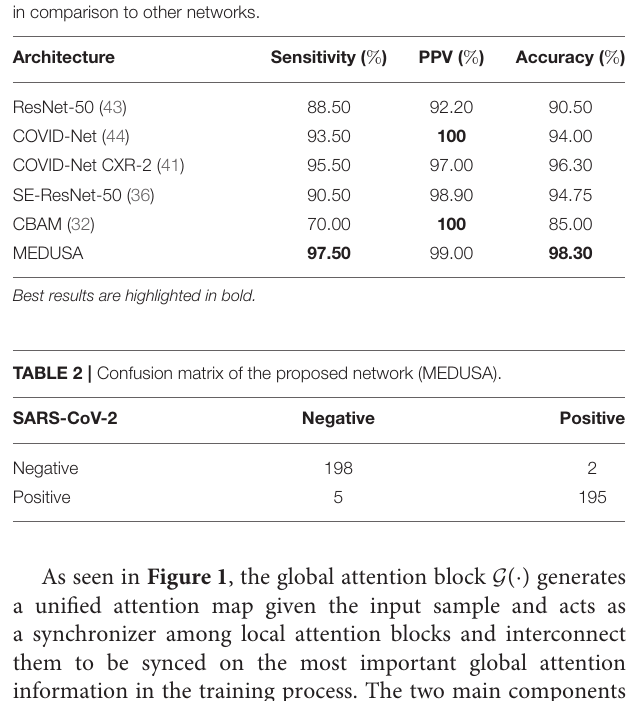
TABLE 1 | Sensitivity, positive predictive value (PPV), and accuracy of the proposed network (MEDUSA) on the test data from the CXR benchmark dataset in comparison to other networks.